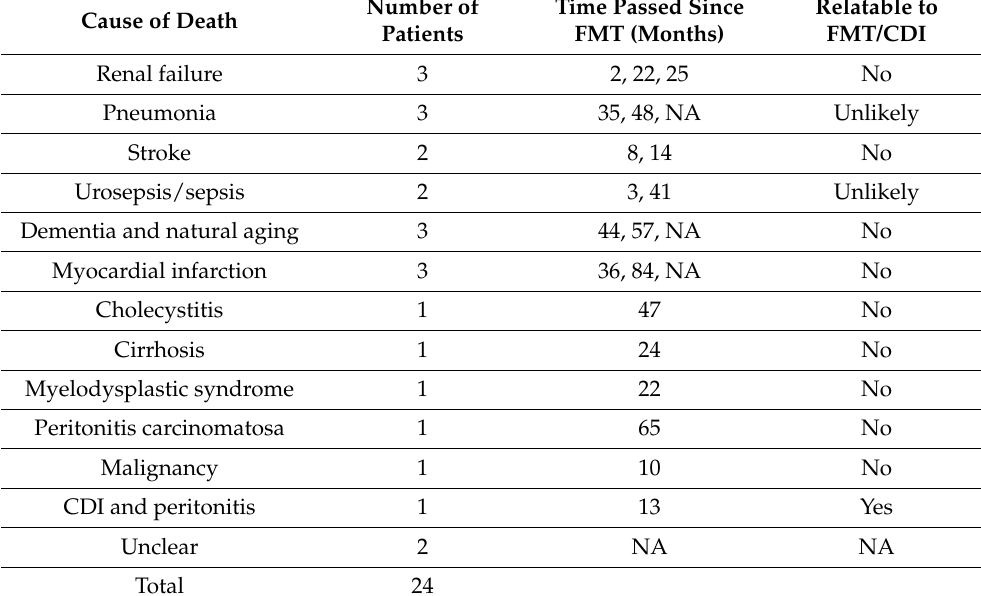
Table 2. Cause of death, time between FMT and death, and possible relation with FMT from patients in the FECAL trial during long-term follow-up after FMT treatment and cure of rCDI. Number of Time Passed Cause of Death